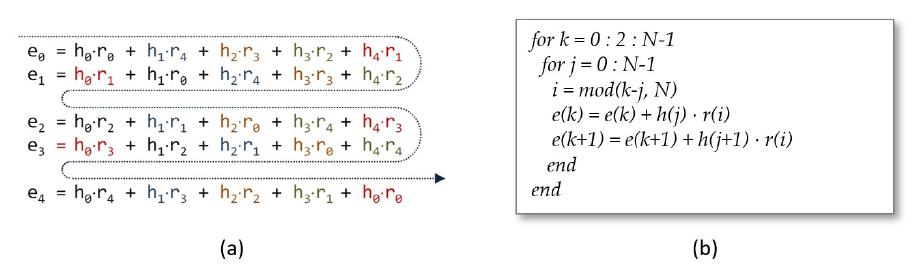
Figure 3. Simultaneous evaluation of two terms of the summation ( a ) and generation of indices i , j , and k ( b ) when the convolution matrix is swept by rows (colors indicate the terms evaluated in